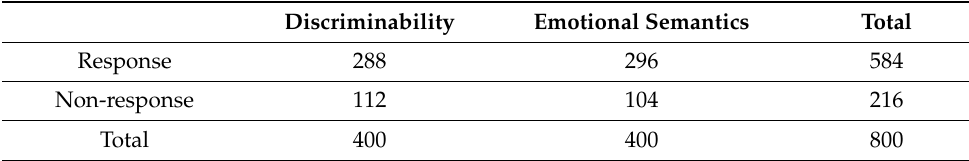
Table 8. Chi-square analysis results for response rate.